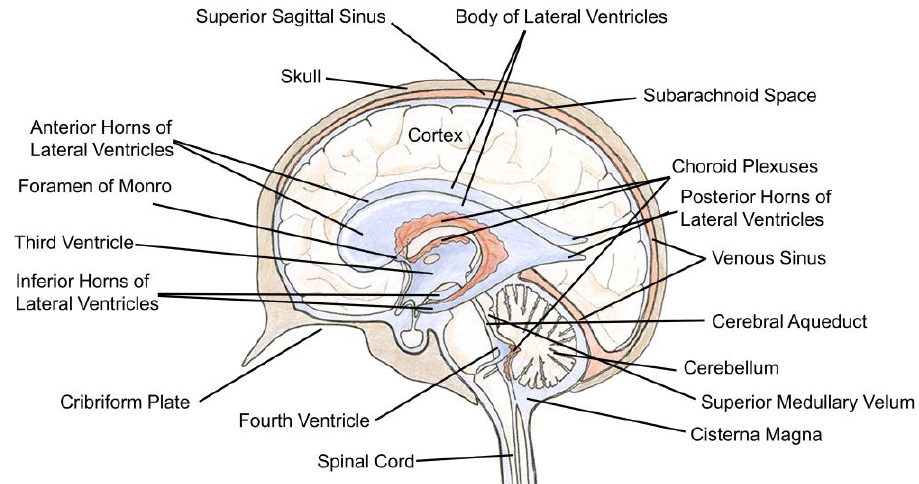
Figure 1. Anatomy of the brain and ventricular system. Image depicting the location of a number of structures covered within the current review. Cerebrospinal fluid is indicated by a light blue and the choroid plexuses are represented with a shade of red. Adapted with permission from [35], American Chemical Society, 2013.